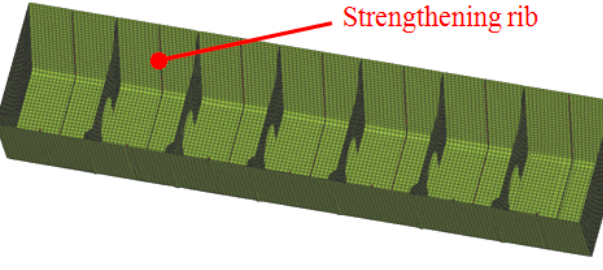
Figure 13. Structural improvement of oil sump.